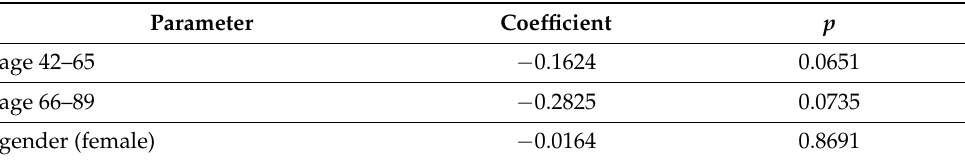
Table 6. Multivariate linear regression analysis of the association between age, gender, education level, living place, professional work mode and daily lifestyle